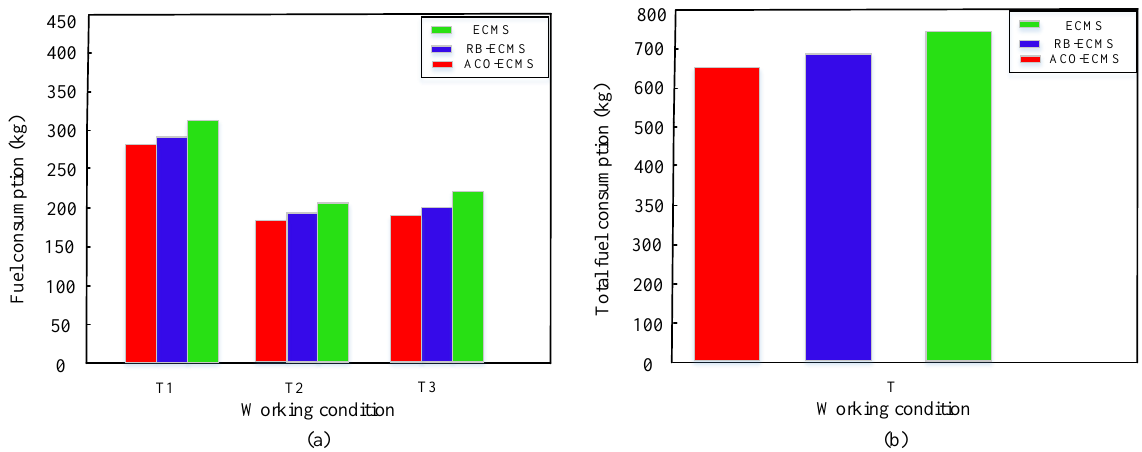
Figure 17. ( a ) The comparison of each condition fuel consumption. ( b ) The comparison of total fuel